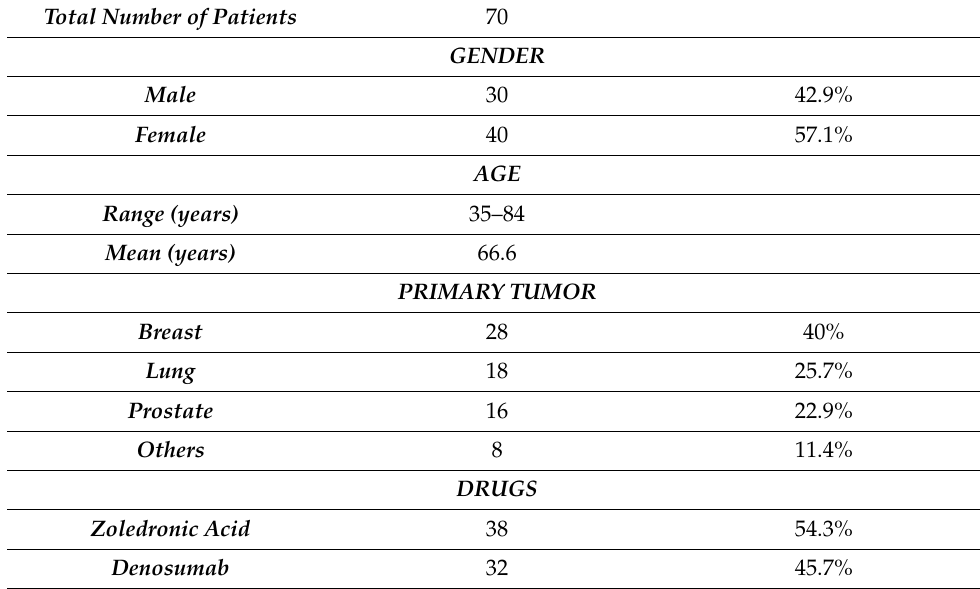
Table 1. Patient